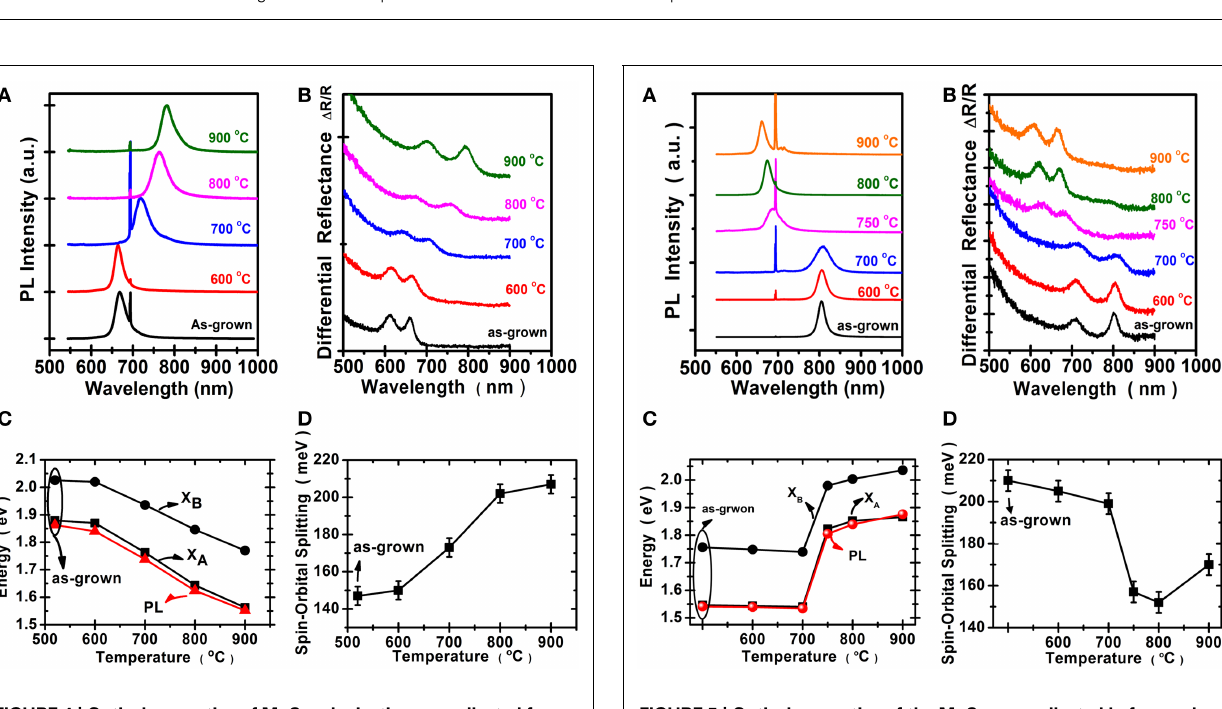
FIGURE 3 | XPS scans for the Mo, S, and Se binding energies for (A) the as-grown MoS 2 and those after selenization, and (B) the as-grown MoSe 2 and those after sulfurization .The magnitude of each profile was normalized for easier comparison.